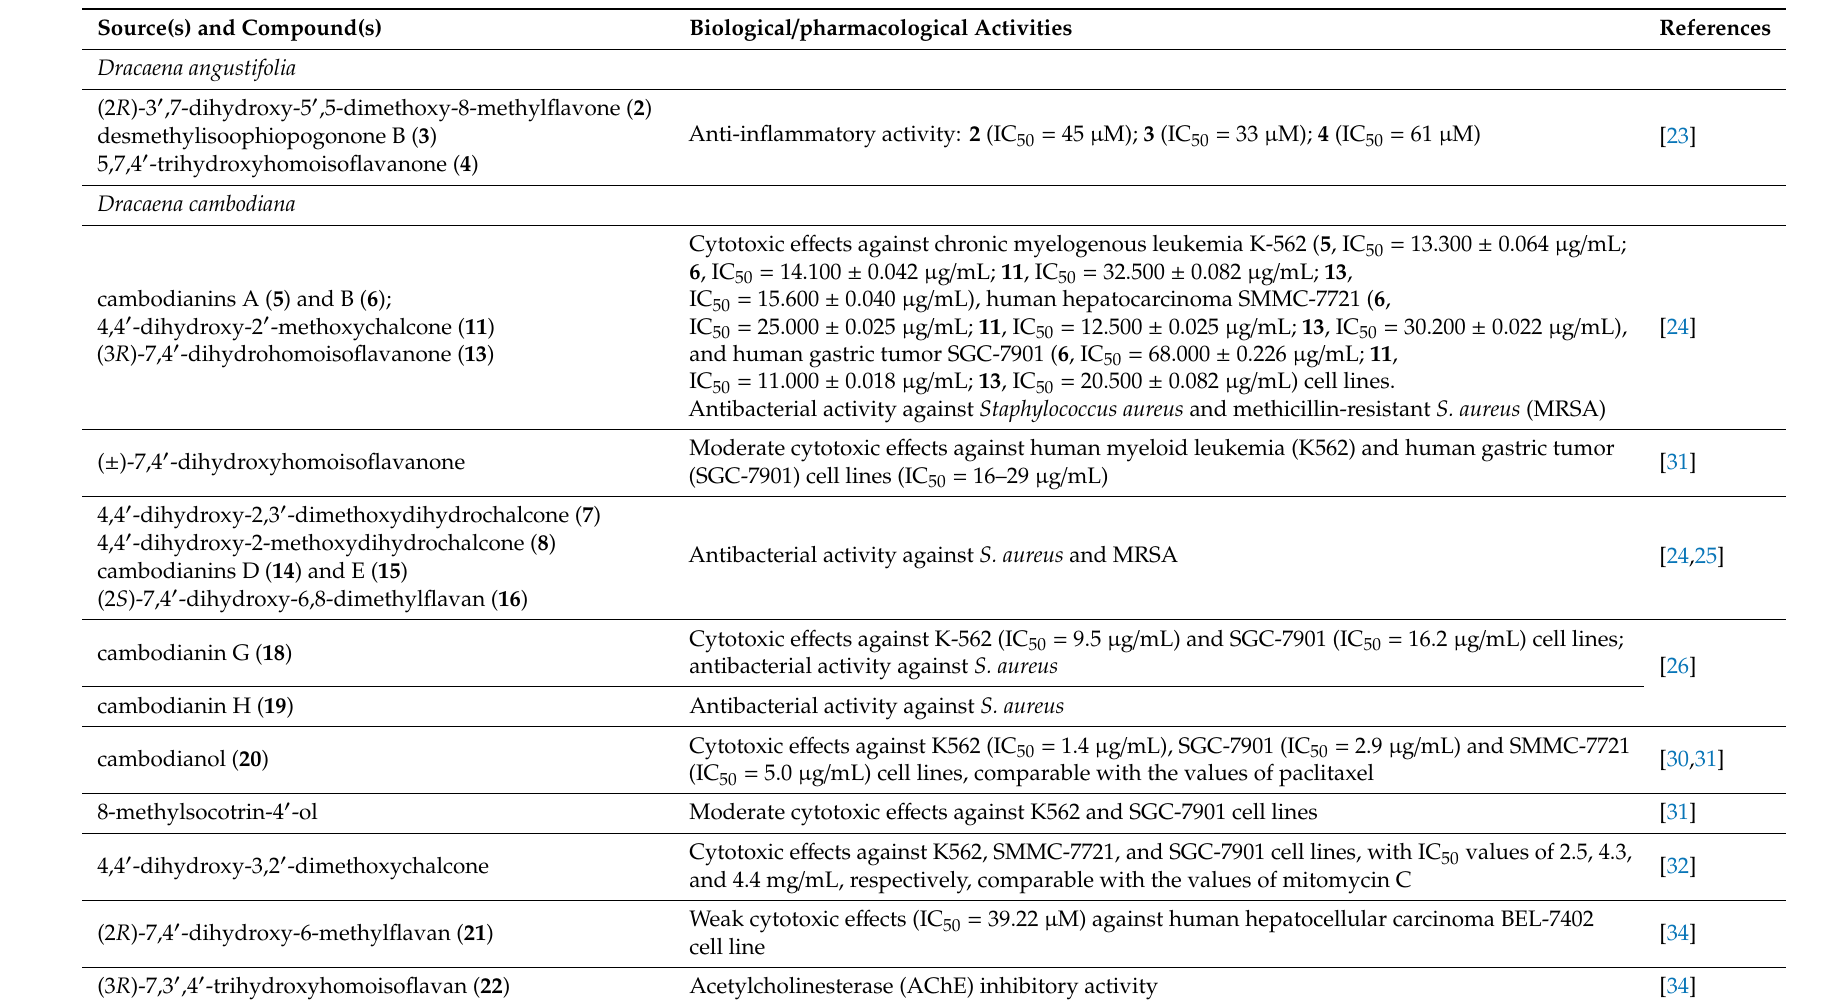
Table 1. Biological / pharmacological activities of characteristic flavonoids and stilbenoids isolated from Dracaena and Sansevieria species. Source(s) and